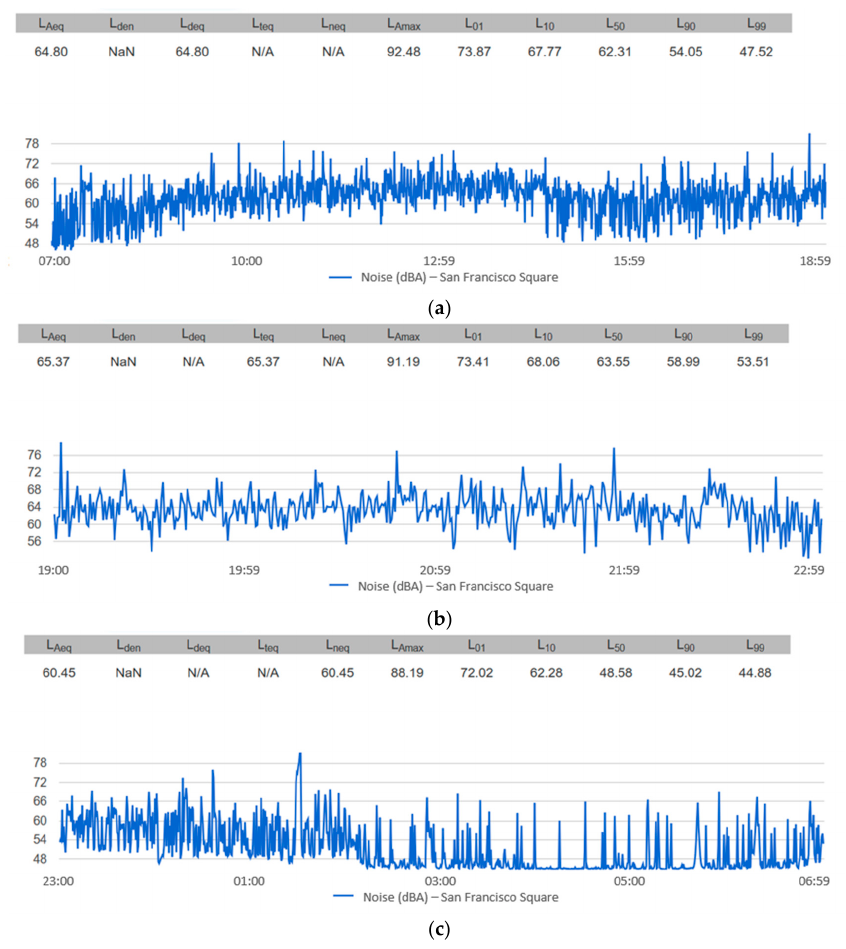
Figure 16. The temporal evolution of the noise on 30 June 2017 in San Francisco Square for the periods: ( a ) daytime 07:00–19:00; ( b ) evening 19:00–23:00; ( c ) night 23:00–07:00.